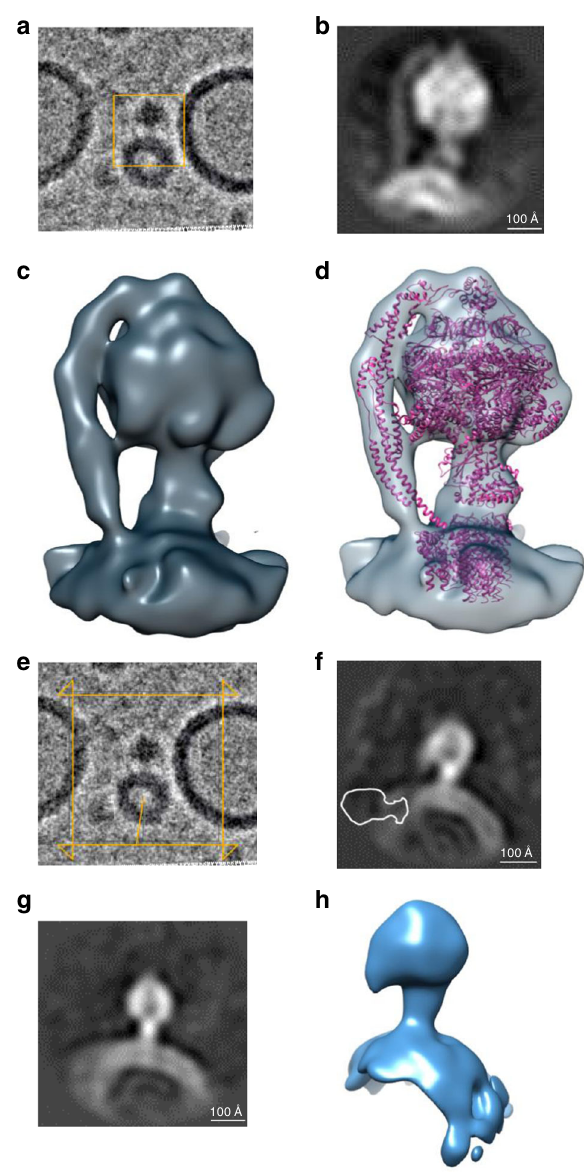
Fig. 2 ATP synthase forms monomers after reconstitution. a Cryo-EM image of small unilamellar vesicles reconstituted with ATP synthase. For initial particle picking a 96-pixel box at 2.8 Å/pixel was used for particle picking and 3D reconstruction. b The resulting 19 Å resolution map of porcine ATP synthase monomer in liposomes. 7795 particles were used for reconstruction of the 3D map after vesicle subtraction. c 19 Å cryo-EM structure of ATP synthase in a liposome. d The cryo-EM structure of bovine ATP synthase (5ARA) (4) was fi tted into the 3D reconstruction of porcine ATP synthase. e The cryo-EM image shown in a of small unilamellar vesicle-reconstituted ATP synthase is shown here again with a larger box size (128-pixel box, 4.2 Å/pixel), which was used to accommodate dimers. f, g The side and front slice views of the resulting 30 Å resolution map from 6655 particles. Density for a second ATP synthase monomer was not found in the map. The outlined image in f represents the expected location of the second monomer (at 86° angle position) if it were to be present in the map. h A surface rendered view of the 30 Å resolution map. c , d , and h of this fi gure were generated with Chimera 62 . ATP synthase models from a and e have been deposited into the Electron Microscopy Data Bank (accession codes EMD-21001, EMD-21002,